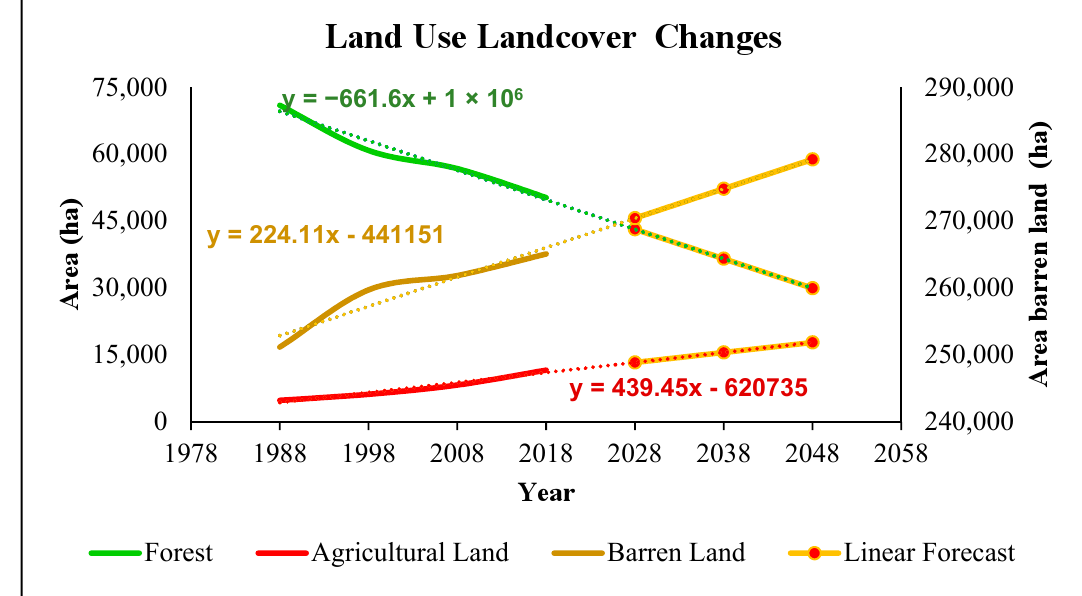
Figure 4. Land-use change trend (1988–2018) with inferred values for future 30 years using linear forecast.